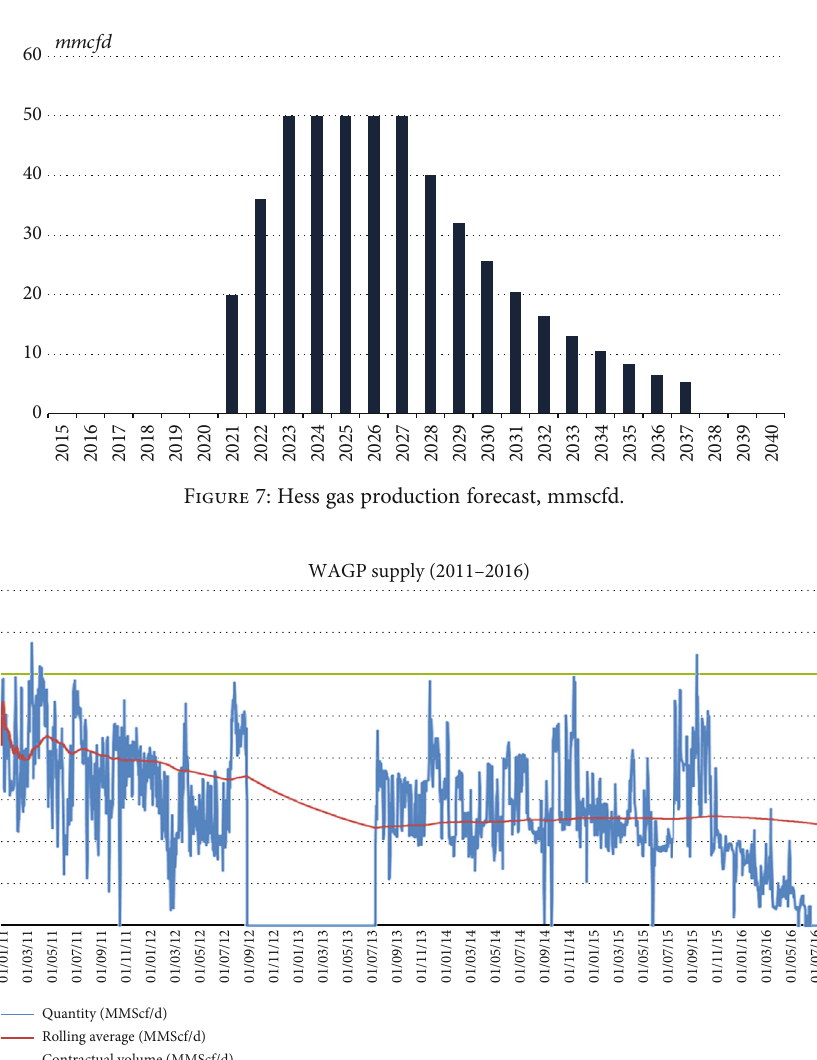
Figure 8: Erratic nature of gas supply from WAGP.